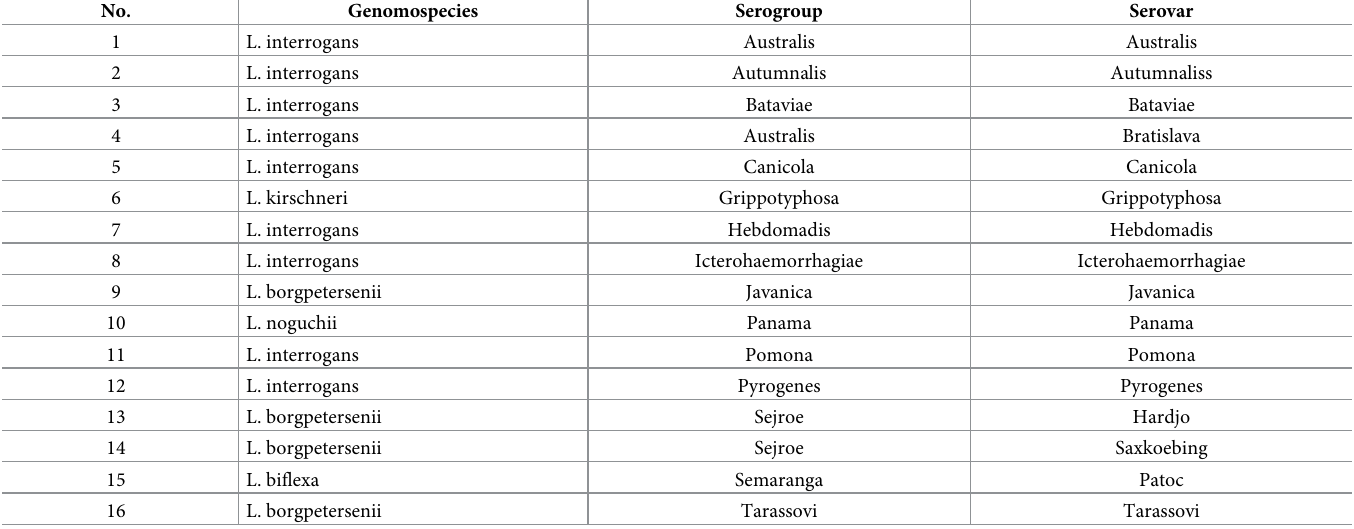
Table 1. List of Leptospira antigens used in the